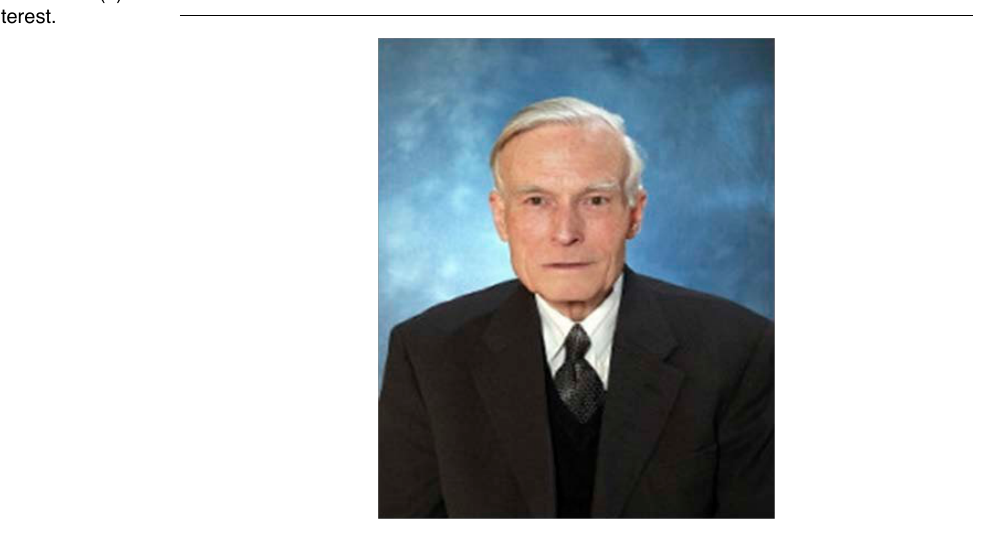
Figure 1. Endel Lippmaa (Photo 1970-s. Author